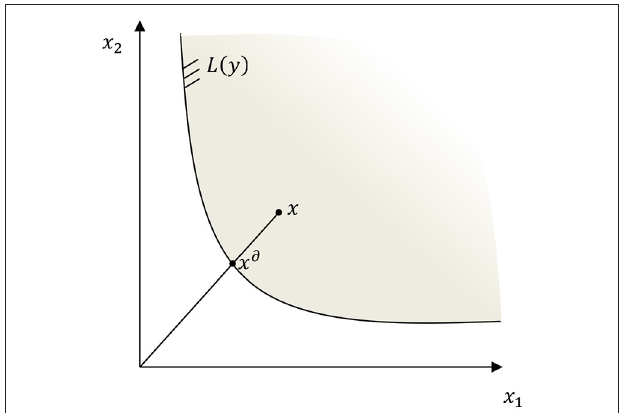
FIGURE 1 | Input distance